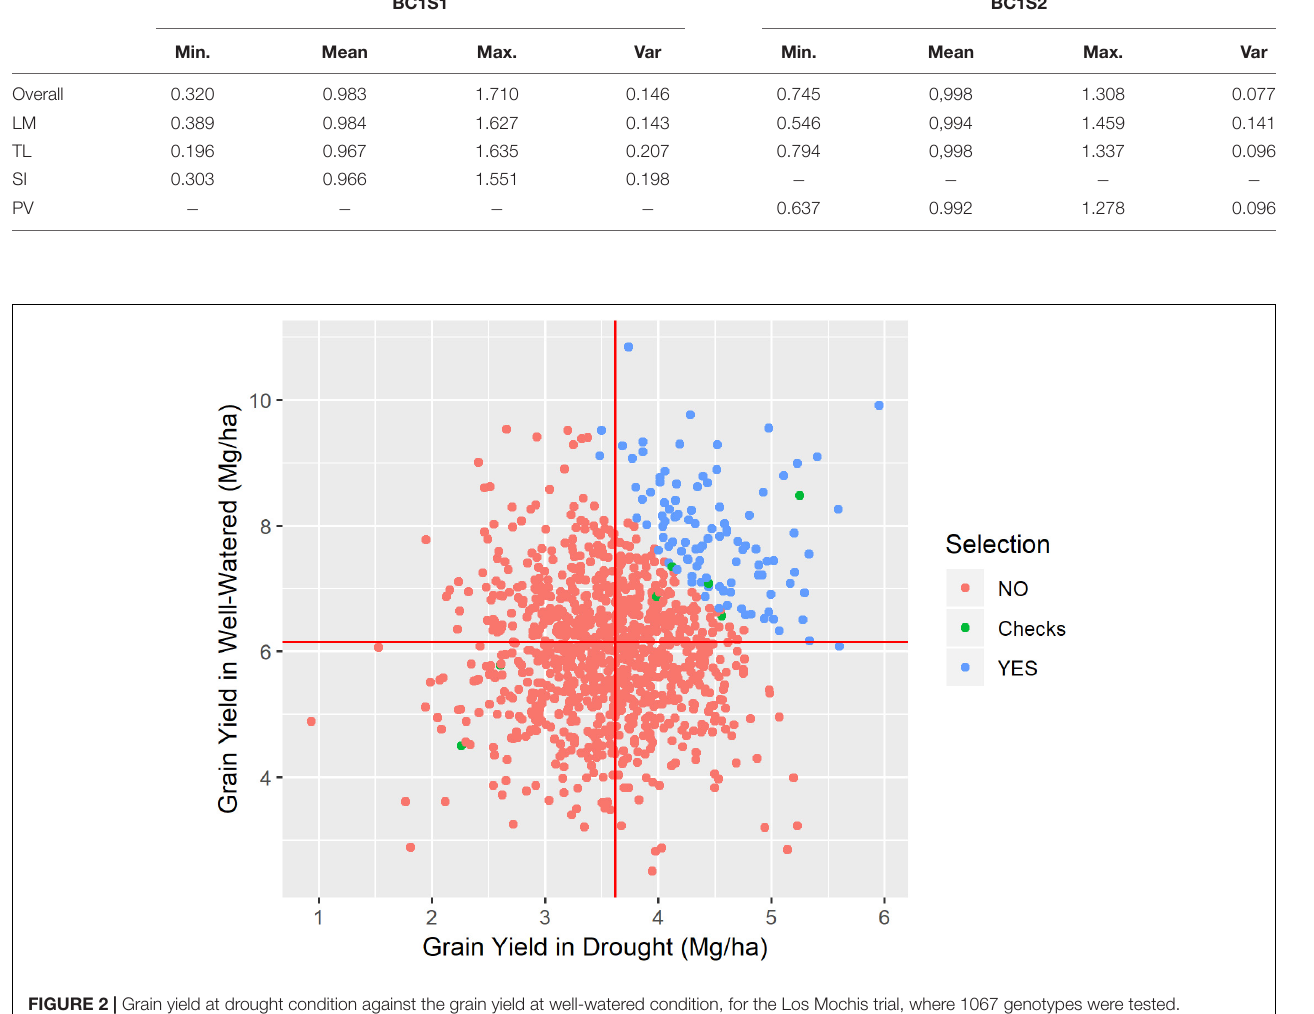
TABLE 4 | Minimum, mean, maximum, and variance of drought tolerance index for each site (LM, Los Mochis; TL, Taltizapan; and SI, Santiago del Ixcuintla) and overall sites for the generation BC1S1 and BC1S2. BC1S1